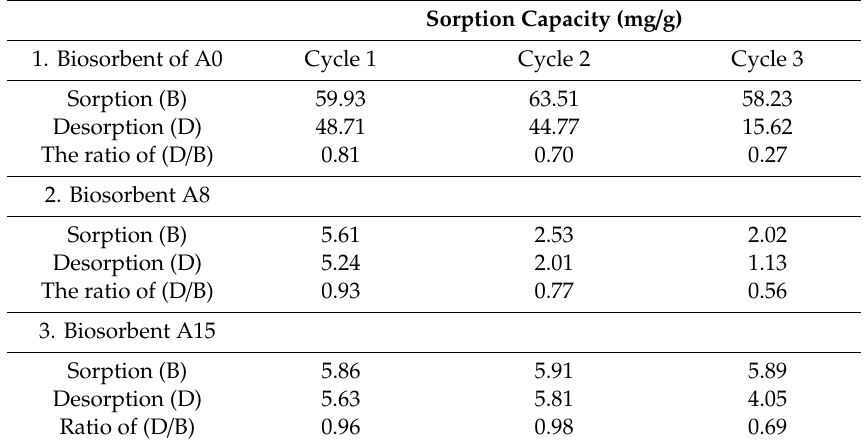
Table 7. Reusability of three Aphanothece sp. biosorbents on sorption of Cd 2 + in aqueous